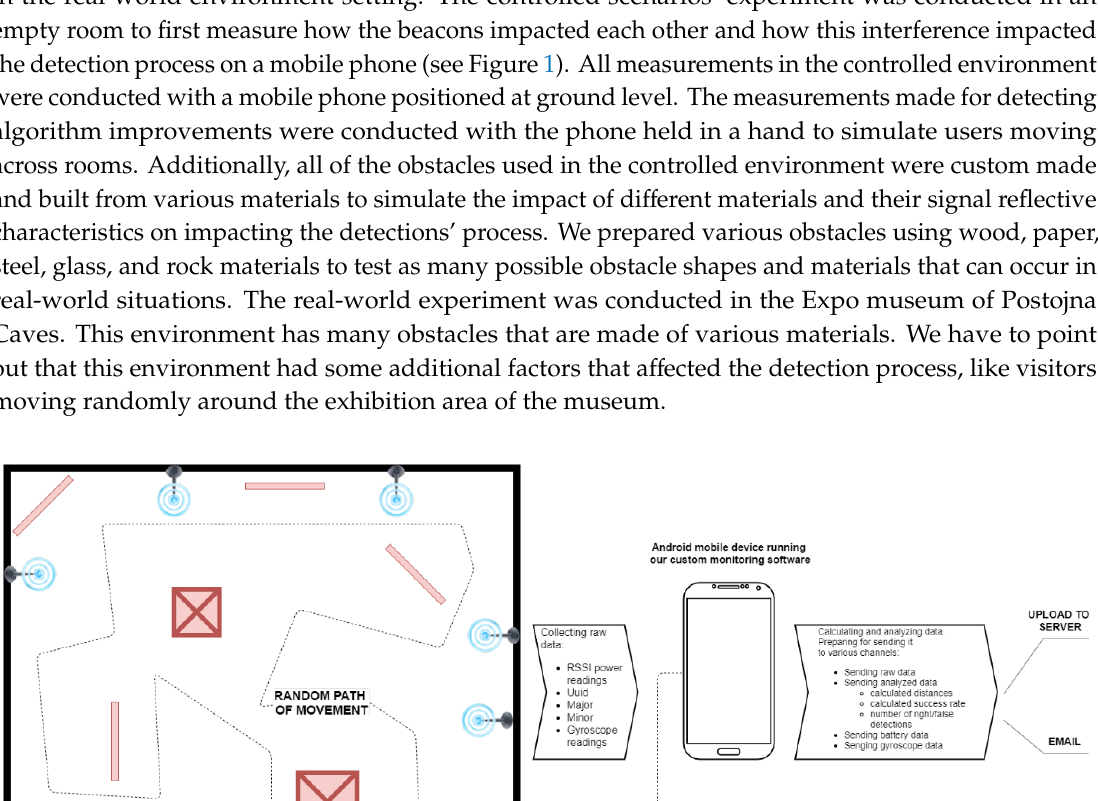
Figure 2. The conceptual research model.